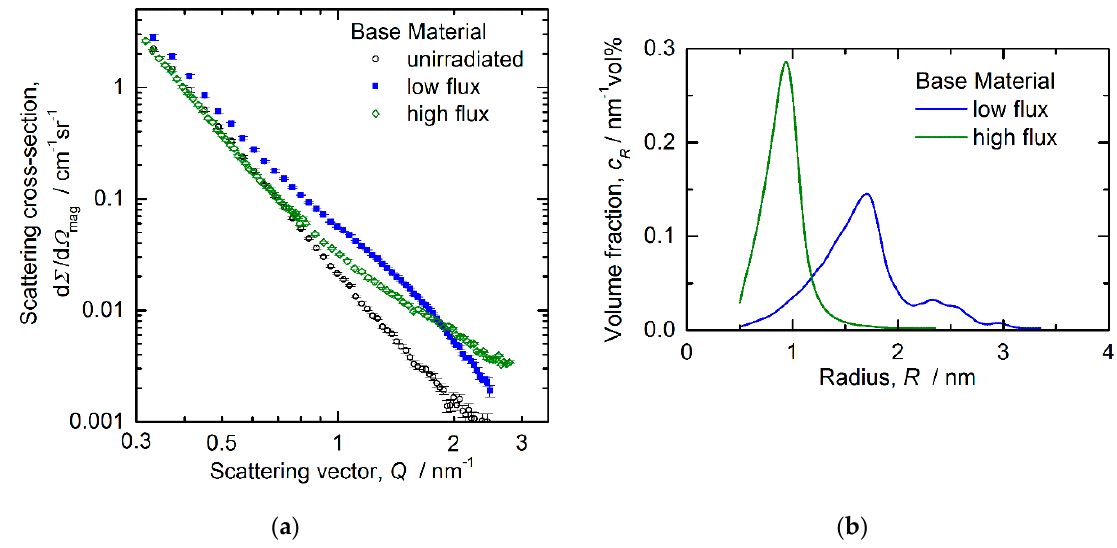
Figure 7. Results from magnetic SANS for the RPV base material, ( a ) magnetic scattering cross sections, ( b ) reconstructed size distributions of irradiation-induced scatterers.